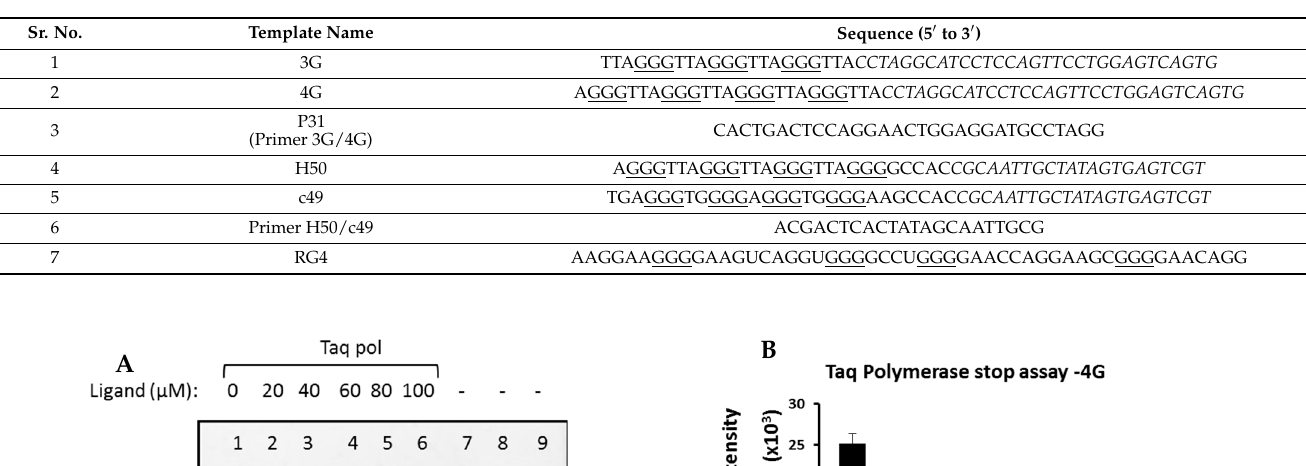
Table 1. Oligonucleotide sequences used in the current study. Primer binding region is given in italics and G-runs are underlined in each template sequence.